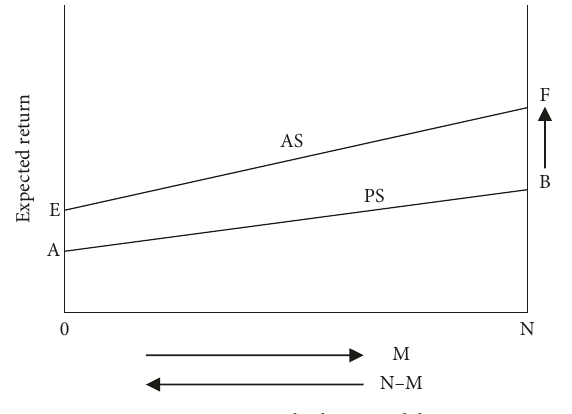
Figure 1: Smooth slope